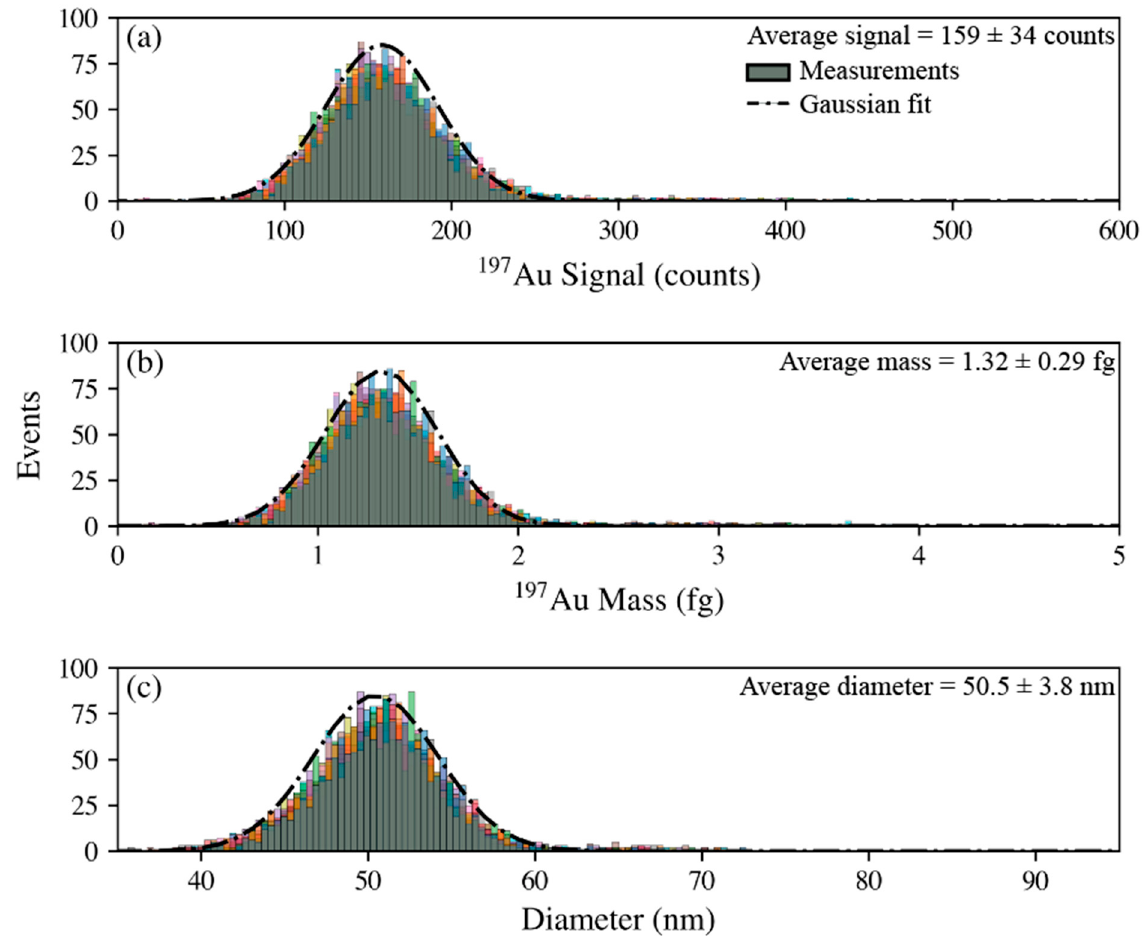
Figure 3. Representative demonstration of particle size calculation for the 50 nm Au NPs ( n = 10) based on the ( a ) counts, ( b ) mass, and ( c ) calculated size presented as histograms regarding the frequencies of events.